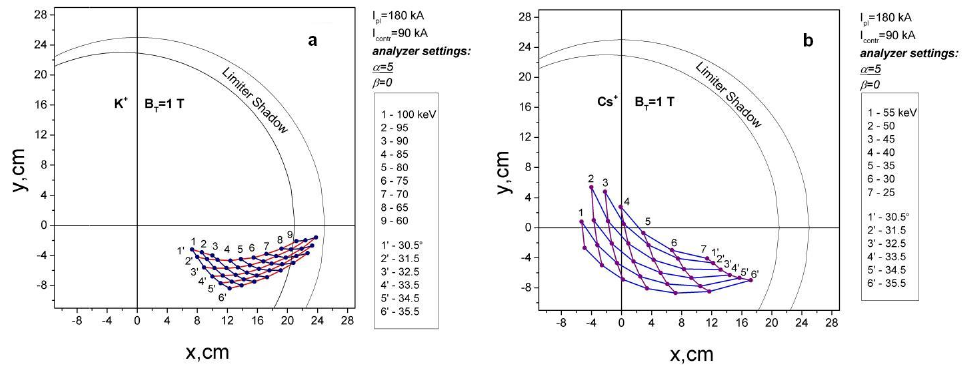
Figure 2. HIBP detection grids for K + ( a ) and Cs + ( b ) primary ions. Toroidal field B T = 1T, plasma current I p = 180 kA.